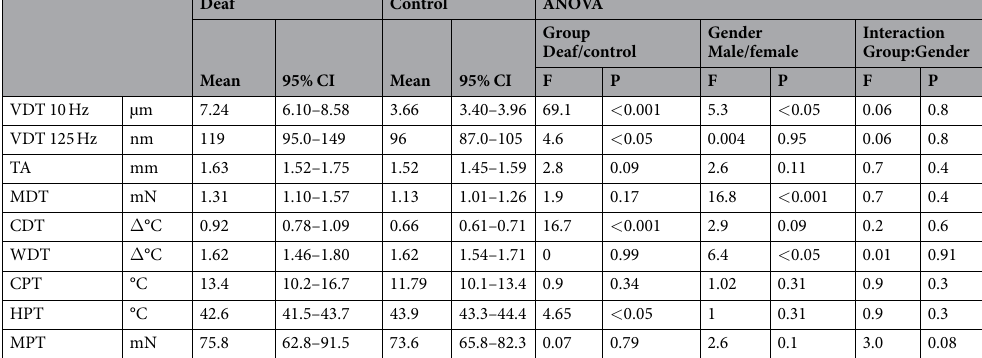
3 Scientific RepoRts | 7: 4251 | DOI:10.1038/s41598-017-04074-0